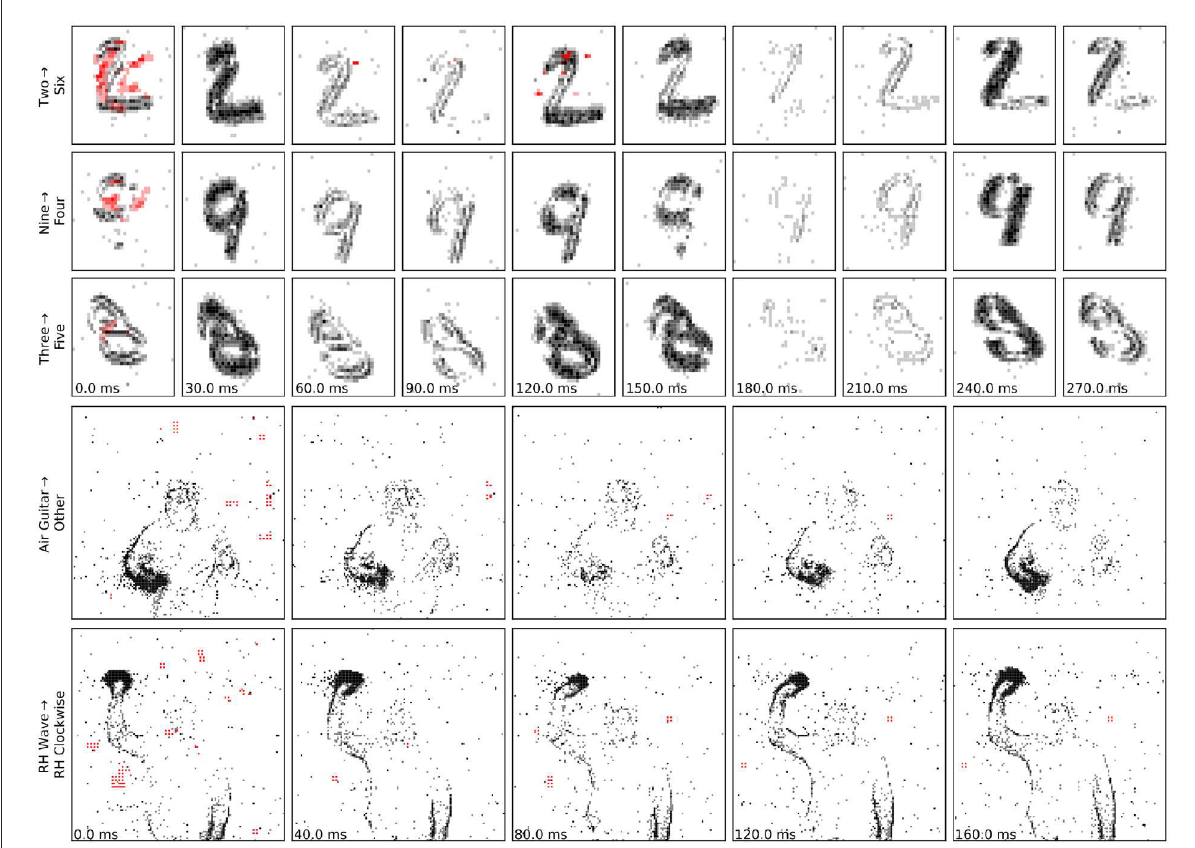
FIGURE3 Examples of adversarial inputs on the, Neuromorphic MNIST (top) and IBM Gestures (bottom) datasets, as obtained by the SpikeFool method. The captions show the original (true) label, correctly identified, and the class later identified by the model. The data was re-framed in time for convenience of visualization. Red indicates added spikes. See the Supplementary Video for more examples and motion